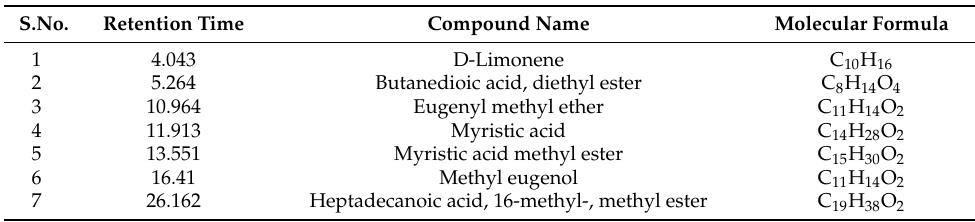
Table 3. GC-MS analysis of Cu nanoparticles of